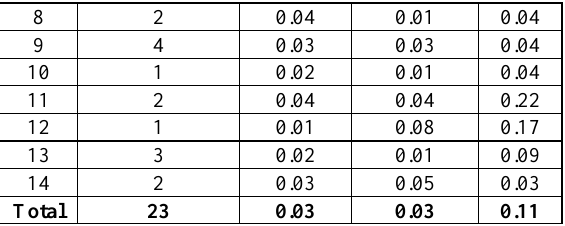
Table 2: Stereo accuracy